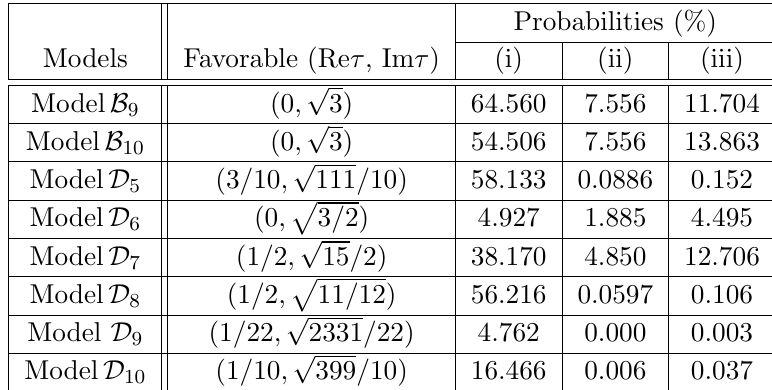
Table 17 . The theoretically favored vacuum expectation values of (Re (cid:28); Im (cid:28) ) within each region for the N max = 1000 case. We also show the probabilities of (i) the favorable value in each model, (cid:13)ux (ii) the favorable value in whole fundamental domain of SL(2 ; Z ) moduli space and (iii) the allowed moduli region in the string